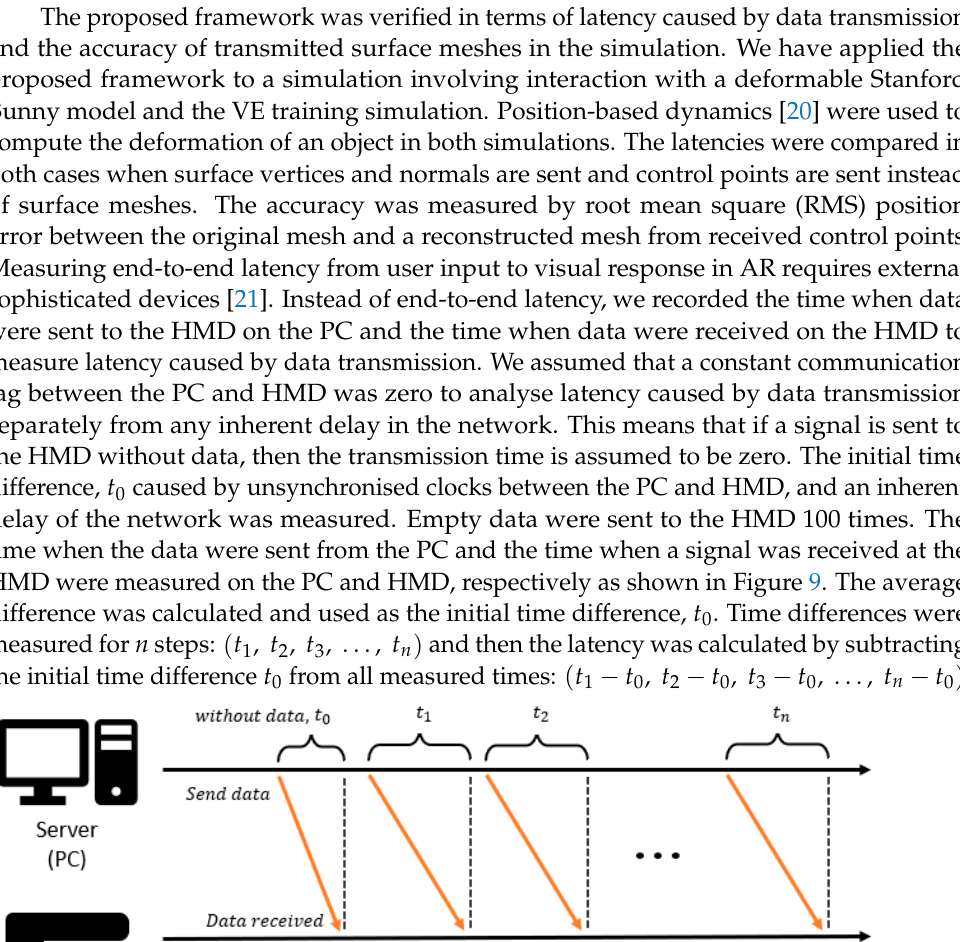
Figure 10. Stanford Bunny model embedded in a lattice of control points (white). In the proposed framework, 48 control points were transmitted to the HMD, and a surface mesh was reconstructed from the received control points. Global deformation was not transmitted in this simulation because no specific scenario was defined. A total of 524 pairs of vertices and normals are needed to directly render the Stanford Bunny model on the HMD without the proposed framework, which will result in 1048 vectors sent to the HMD for 400 steps. The average and maximum latency caused by sending 48 vectors are 281 and 315 ms, respectively. In the case of the proposed framework, only 48 control points are needed to render a virtual scene. The average and maximum latency over 400 simulation time steps caused by sending 48 control points are 6 and 51 ms, respectively. The average and maximum latency are summarised in Table 1.